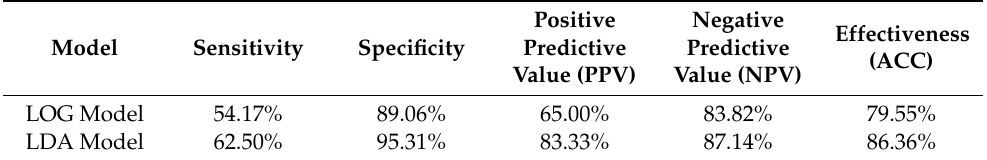
Table 11. Basic parameters of LOG and LDA models as a classifier.